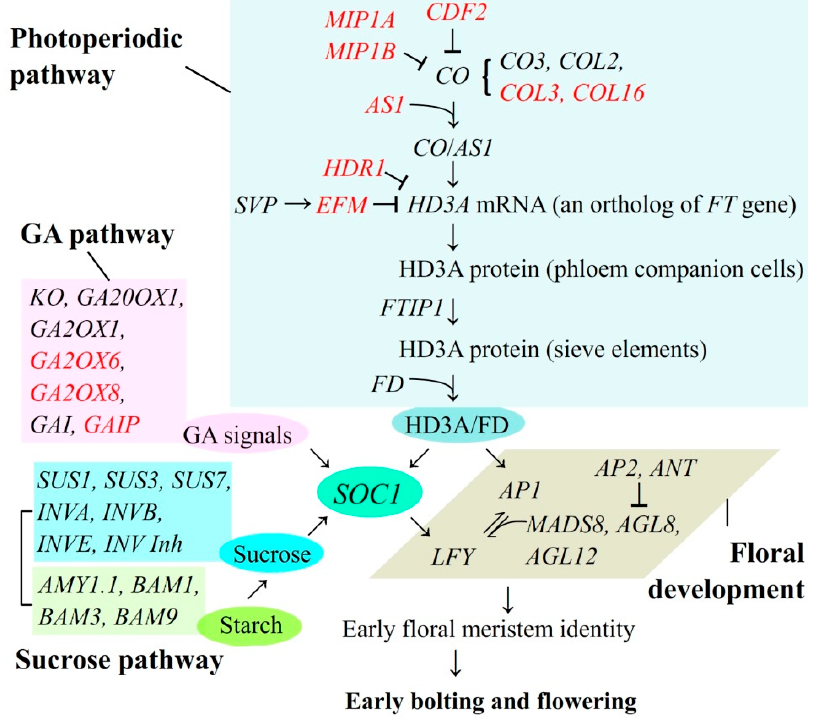
Figure 5. Schematic representation of proposed pathways of DEGs for regulating early bolting and flowering in A. sinensis . Genes highlighted in black represent favoring flowering and genes highlighted in red represent disfavoring flowering.